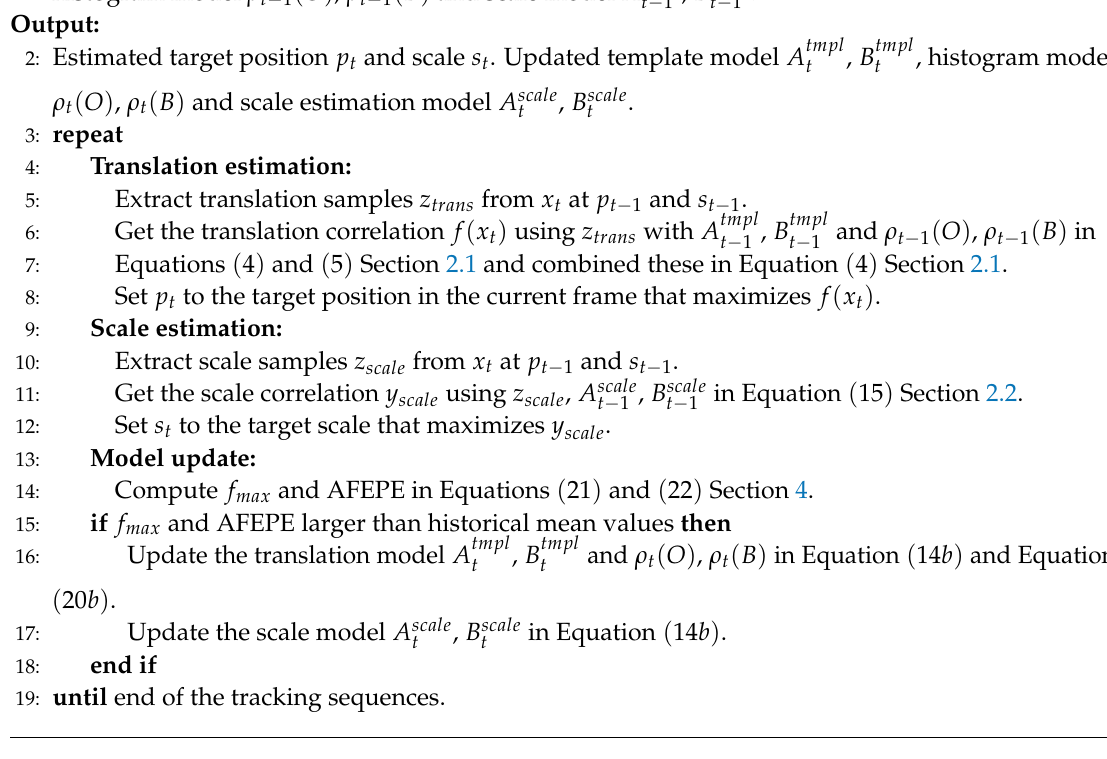
Algorithm 1 Proposed tracking approach: start from step t